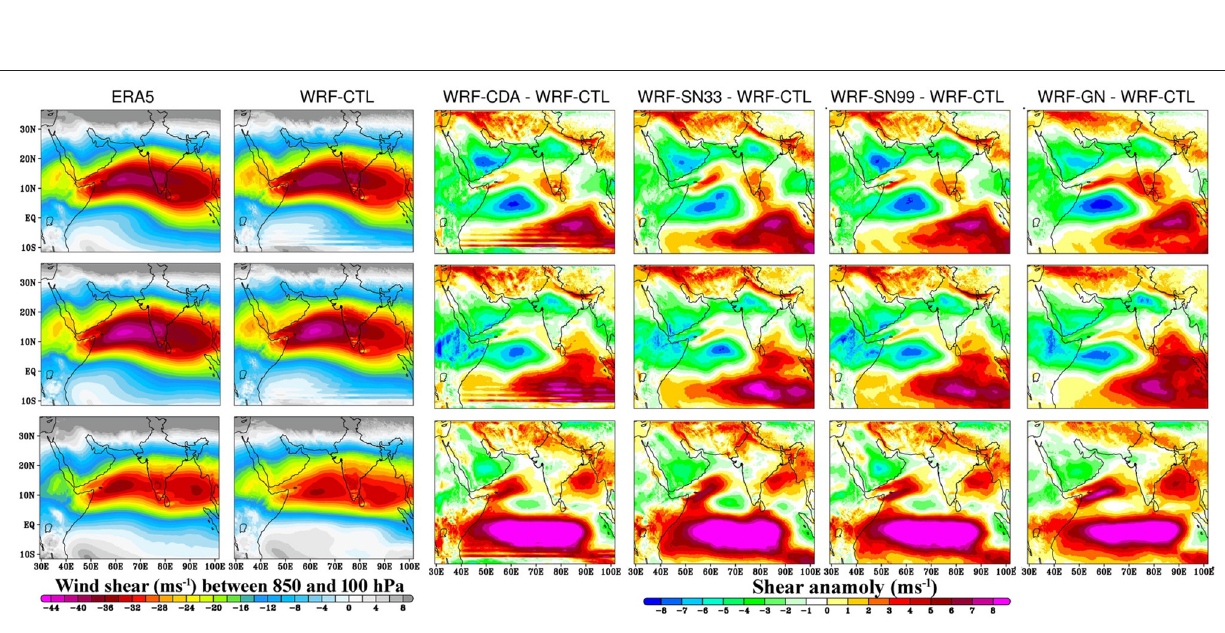
zonal wind over the Indian Ocean induces significant changes in the atmospheric dynamics, which can eventually modulate the convective activities over the ISM region (Reale et al., 2017; Attada et al.,